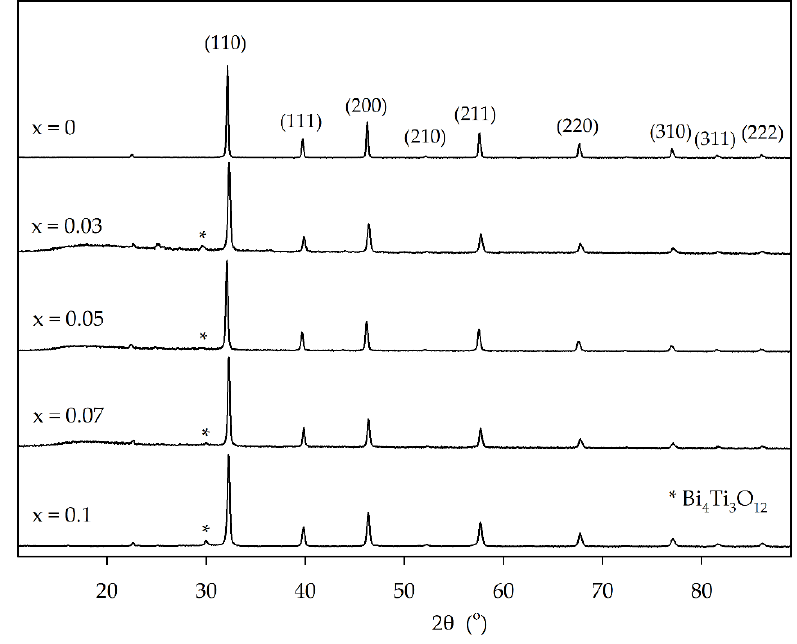
Figure 1. XRD patterns of the Sr 1-x Bi x TiO 3 powder samples. The cell parameters and unit volume, presented in Table 1, vary slightly and in an irregular way with Bi doping, not obeying Végard’s law, which is in accordance with the obtained results, as a pure solid solution for the doped samples was not observed. With the substitution of Sr 2+ cations, with ionic radii of 0.126 nm, by smaller Bi 3+ cations, with 0.117 nm, the unit cell was expected to contract with the introduction of bismuth in the perovskite structure. However, the cell parameters did not follow this tendency and varied irregularly with Bi content. This corroborates the XRD results, showing that a pure solid solution was not